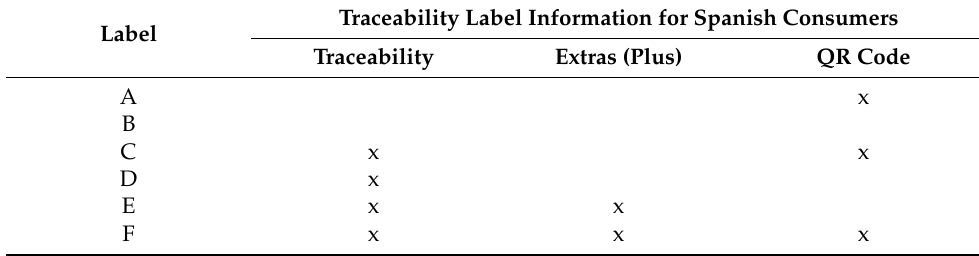
Table A1. Distribution of traceability information on each of the labels presented to Spanish consumers.